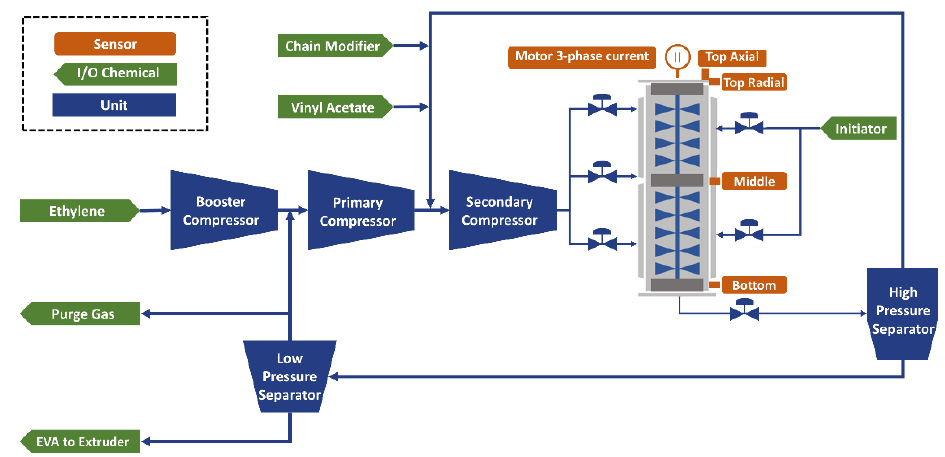
Figure 1. Process schematic of the EVA plant and the reactor configuration diagram.